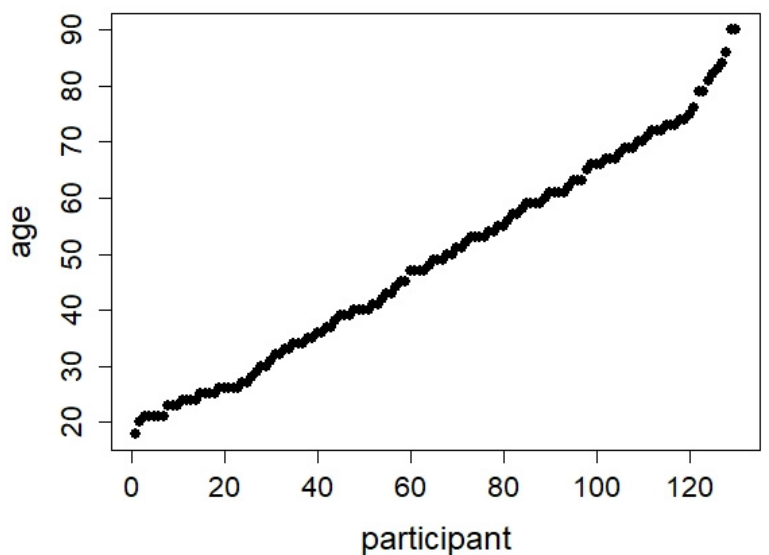
Figure A1. Age distribution of control participants ( n = 130).